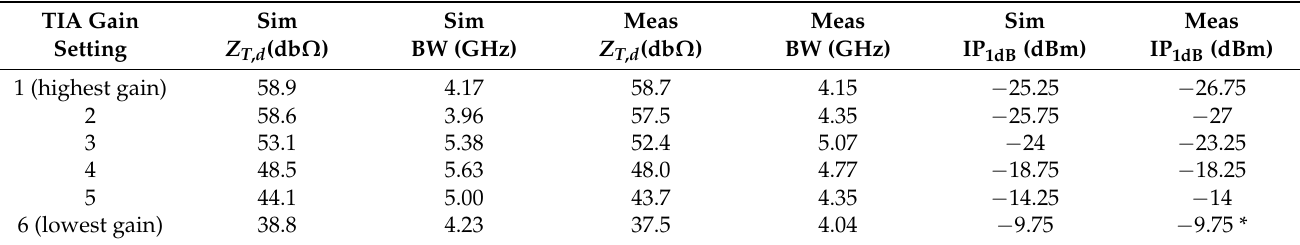
Table 2. Simulated and measured gain, bandwidth and IP 1dB of the